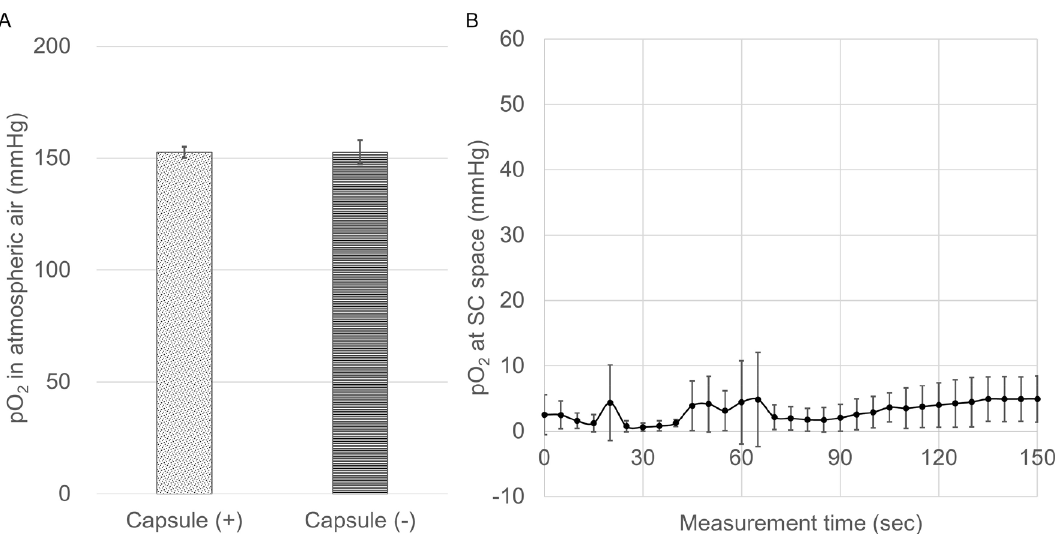
Figure 2. Influence of the interjacent subcutaneous capsule on the optical sensor system. ( A ) To examine the influence of the interjacent subcutaneous capsule on the optical sensor system, the pO 2 of excised subcutaneous tissues at atmospheric air was measured by an optical sensor with or without capsules. There was no significant difference in the pO 2 levels between the capsule (+) group (dotted bar; 152.6 ± 2.6 mmHg, n = 7) and capsule (−) group (horizontal stripe bar; 152.7 ± 5.4 mmHg, n = 7). p = 0.98 (Paired-samples t test). ( B ) Continuous measurement of pO 2 at the SC 1 week after optical sensor implantation using the non-contact method. No increase of pO 2 was detected during the 150-s observation